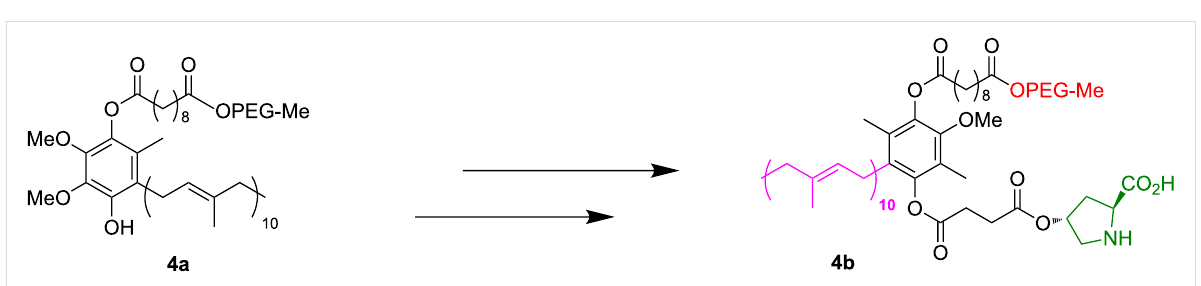
Figure 2: PQS ( 4a ), PQS attached proline catalyst 4b . Adapted from reference [26]. Copyright 2012 American Chemical Society.